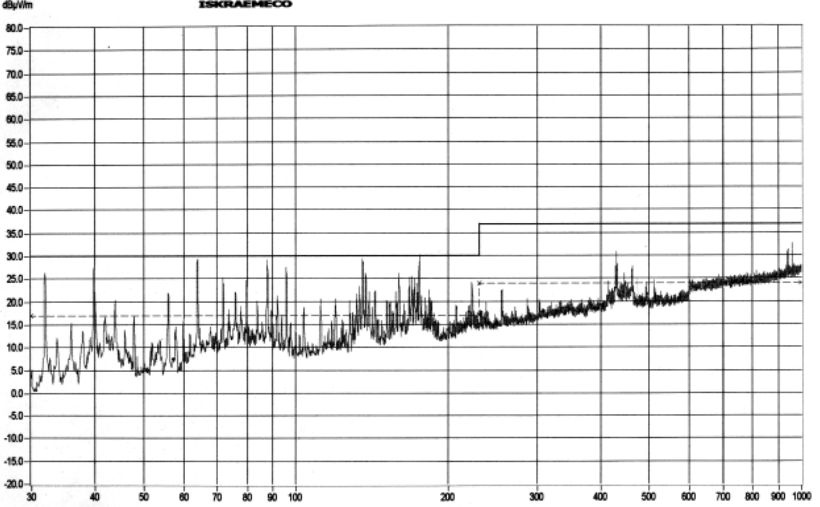
Figure 7. Radiated emission (radiation-based